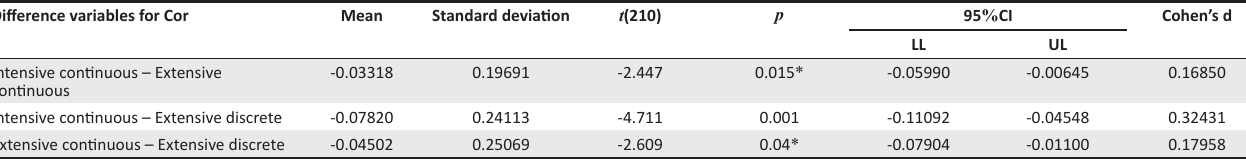
TABLE 6: Differences depending on the type of magnitude for the variable Cor in the Spanish context. Difference variables for Cor Mean Standard